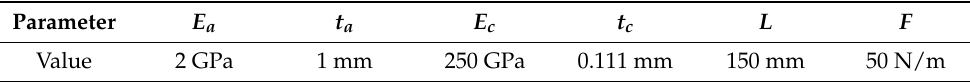
Table 1. Parameters and